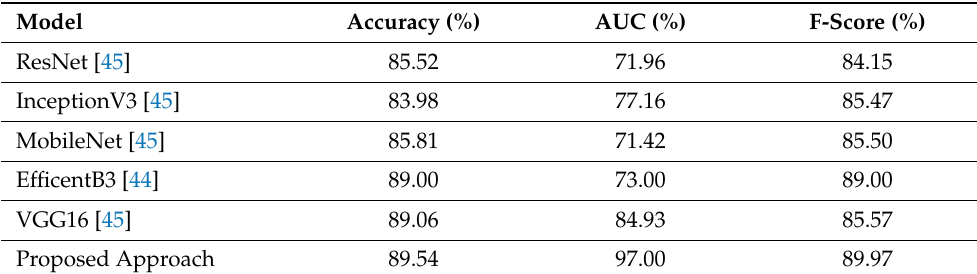
Table 5. The other performance results of the proposed